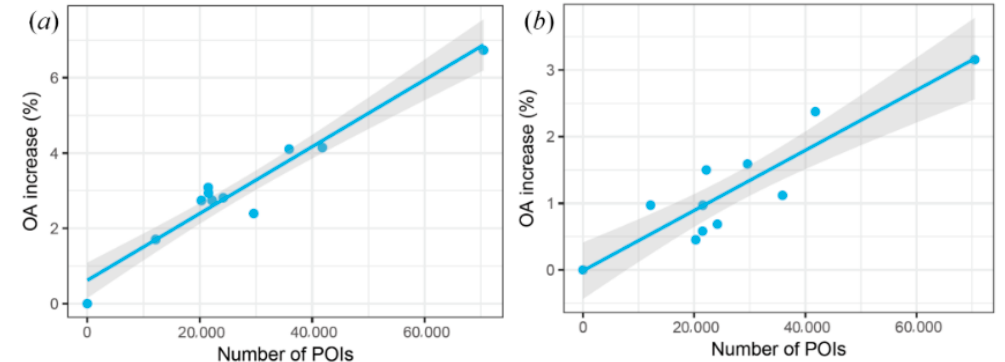
Figure 6. Relationship between the number of POIs (x-axis) and the overall accuracy (OA) increase (y-axis) for SRMIS results. ( a ) The 5-m SRMIS map generated from the Sentinel-2 image; ( b ) The 10-m SRMIS map generated from the Landsat 8 OLI